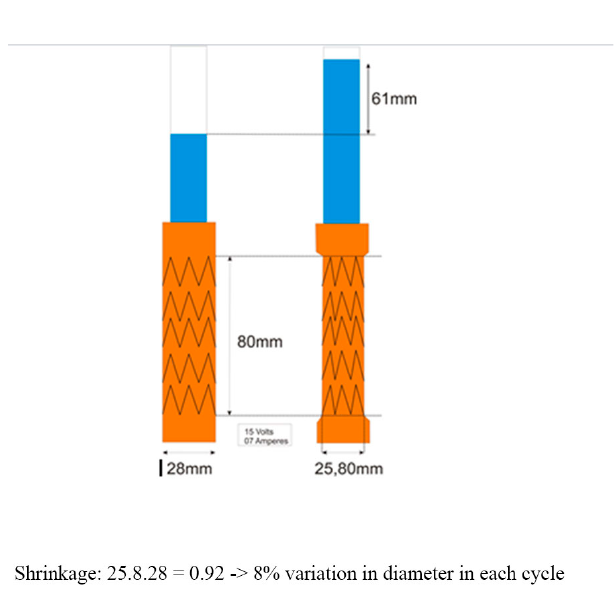
Fig. 6 - Scheme of the second test